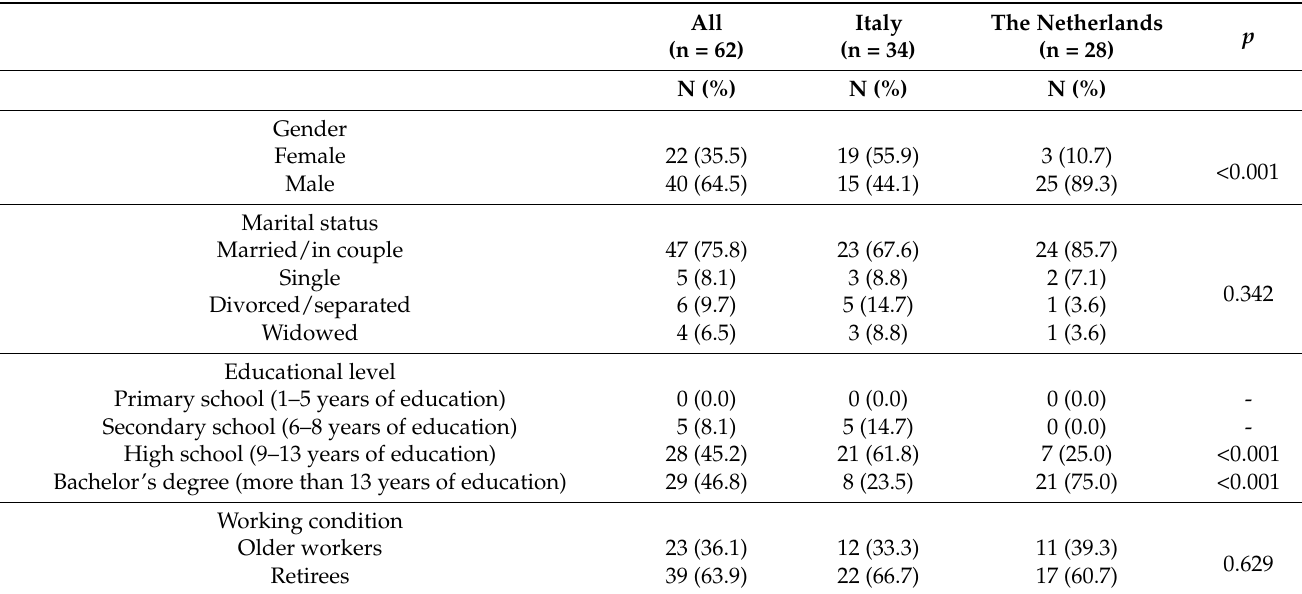
Table 2. Sample description by